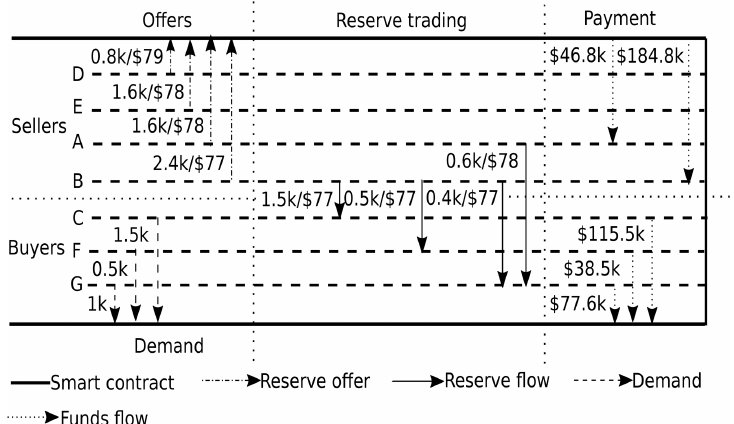
Figure 8. Smart contract execution of reserve trades and payments. Reserve sellers submit their offer (amount of reserve in MWh and cost per unit in $/MWh) to the smart contract. Buyers submit their demand, as well as make payment, to the smart contract, which matches sellers and buyers. The contract then pays successful sellers.